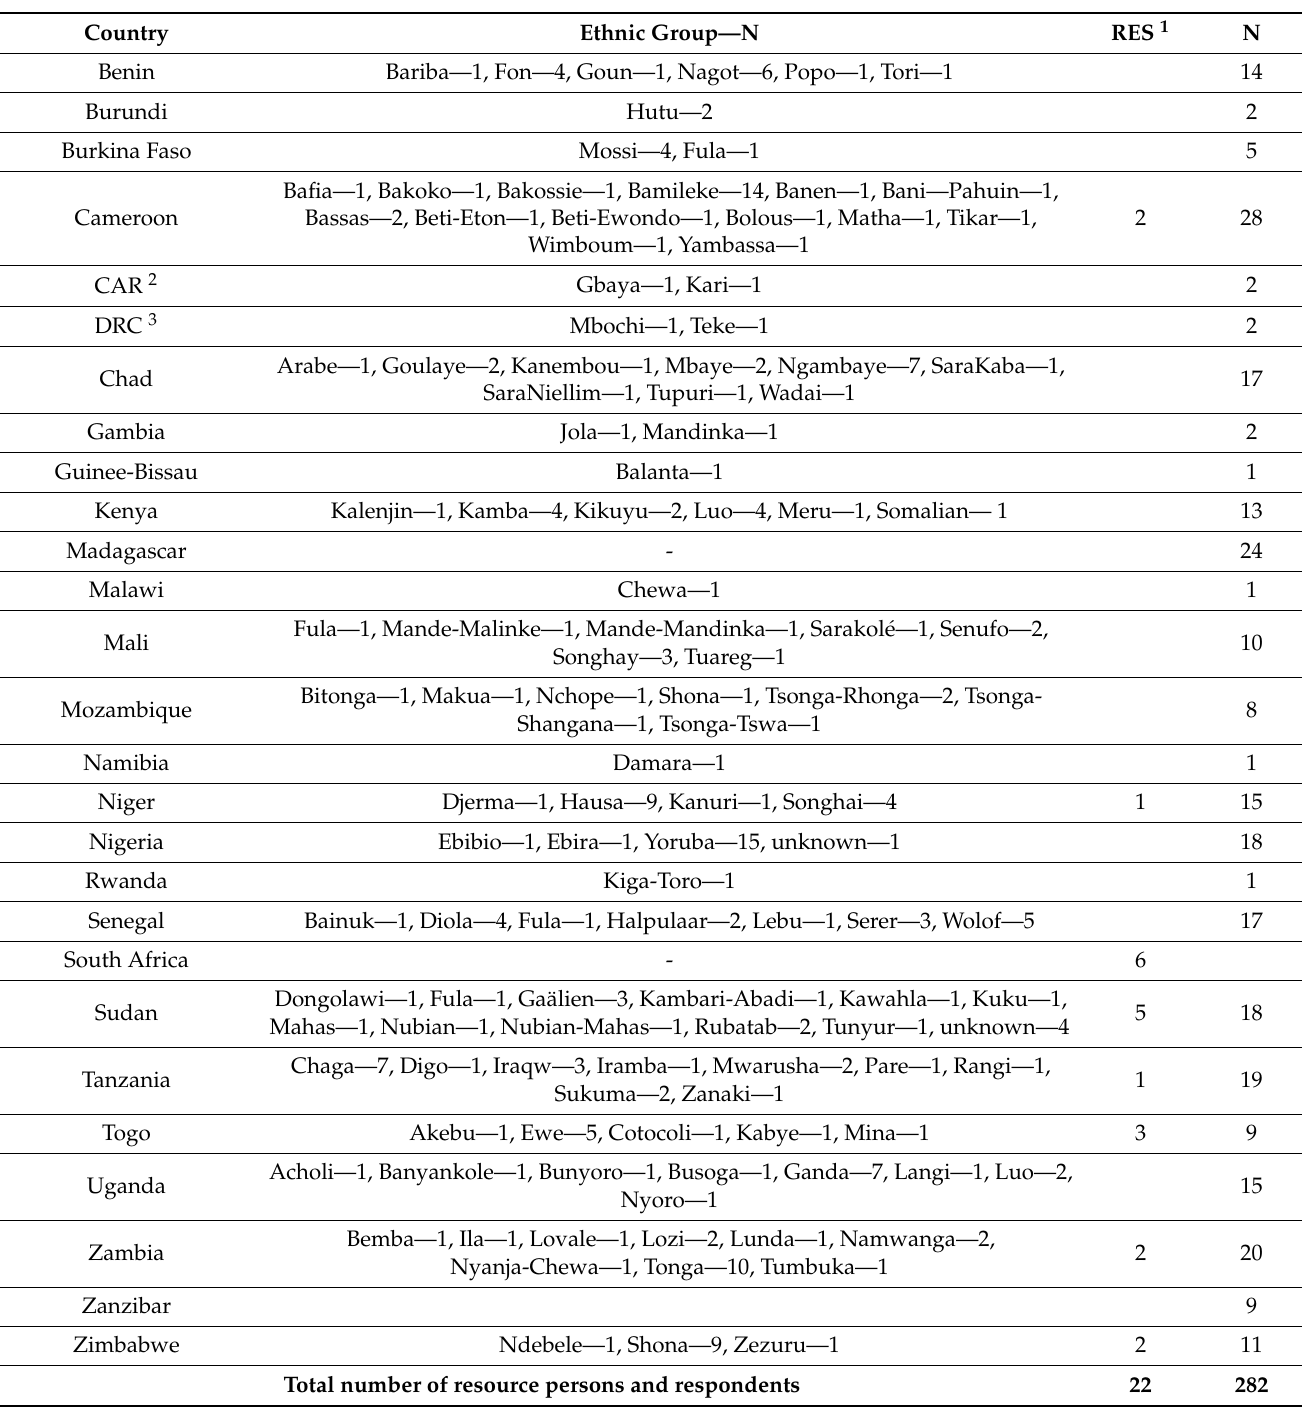
Table 1. The number of respondents (N) per country and ethnic